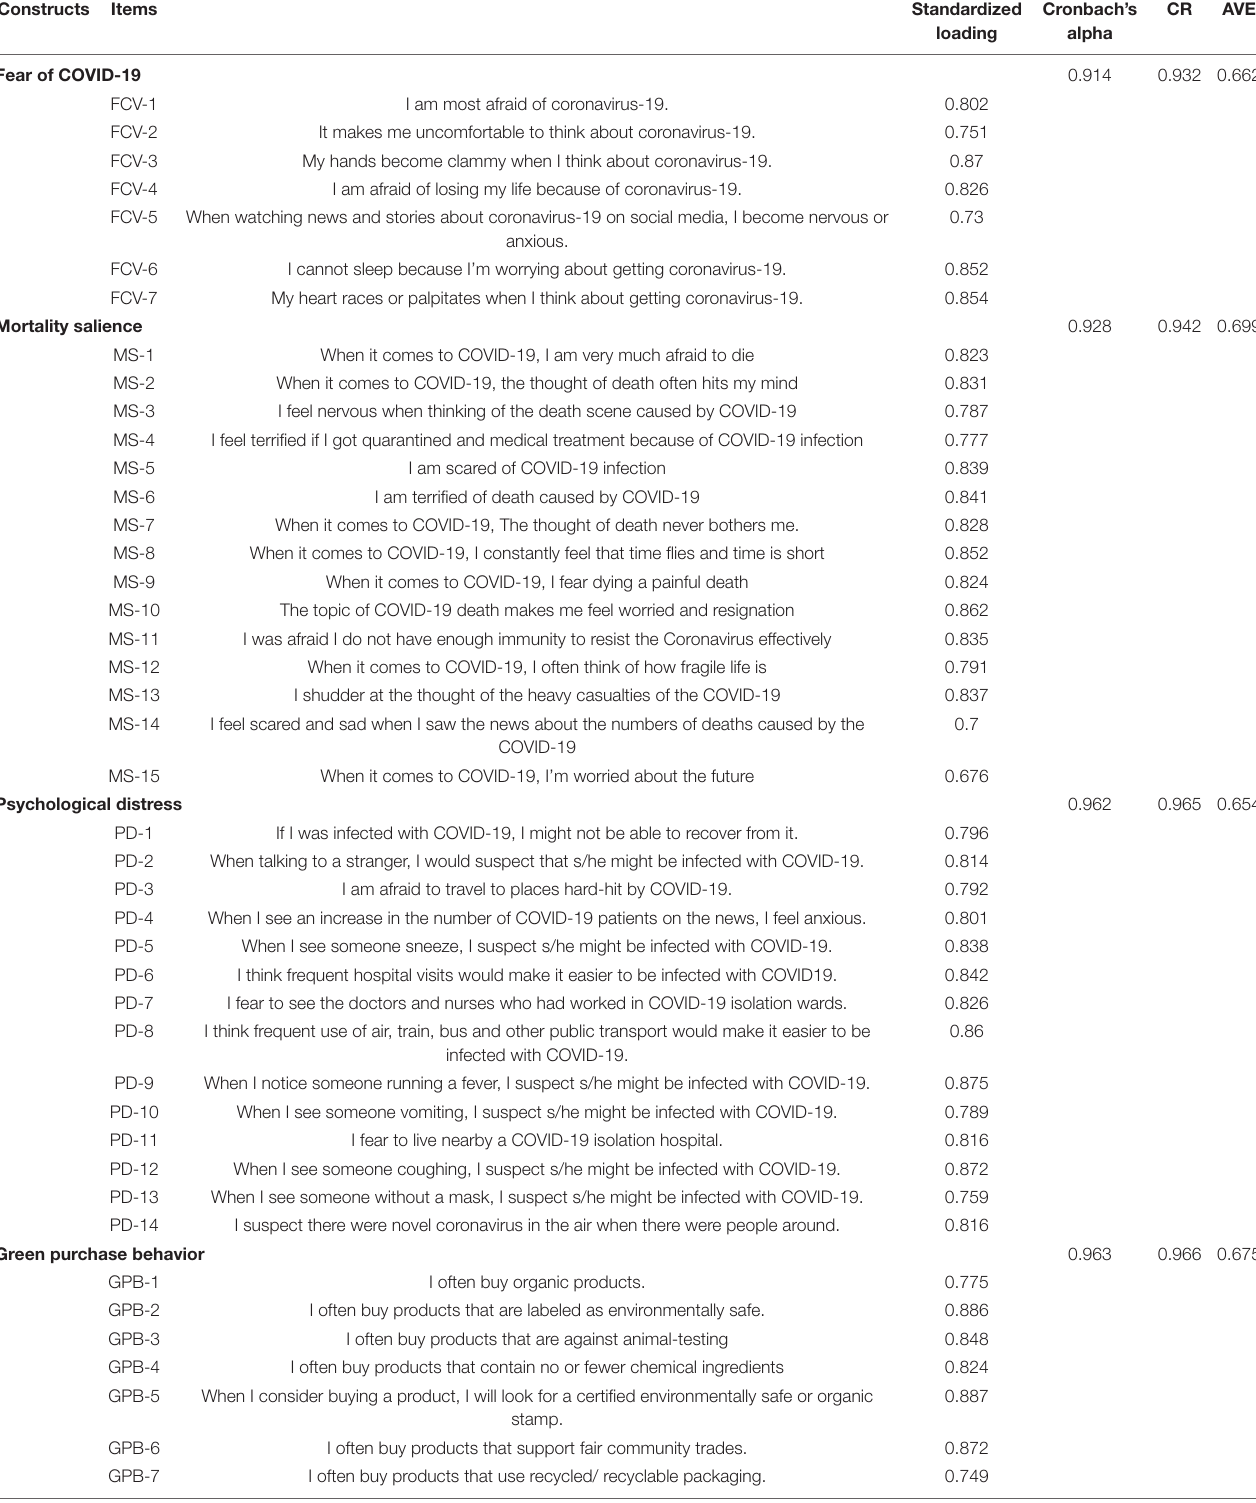
TABLE 3 | Items, Cronbach’s α , standard loading, composite reliability, and average variance extracted (AVE). Constructs